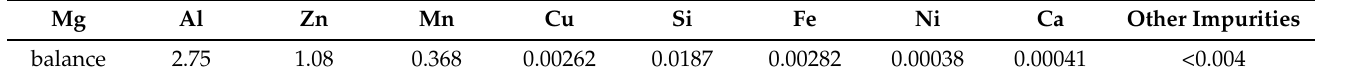
Table 1. Chemical composition of the AZ31B sheet metal in weight percent